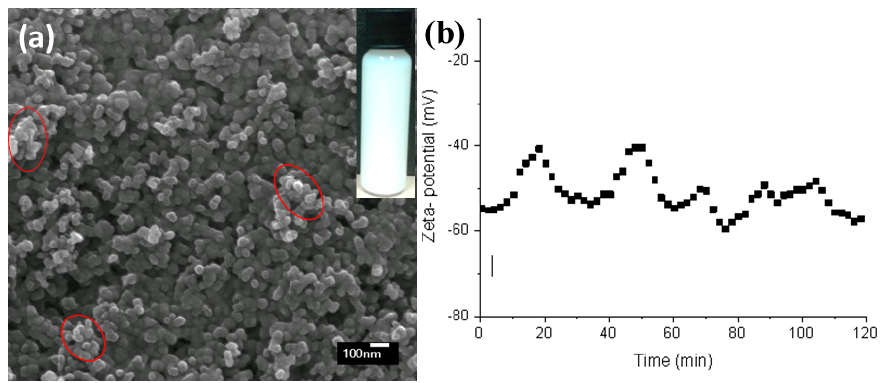
Figure 2. ( a ) Scanning electron microscopy (SEM) image of TiO 2 nanoparticles in the suspension (the inset is the digital image of the sedimentation test of suspension after 7 days); ( b ) zeta potential changes with time.